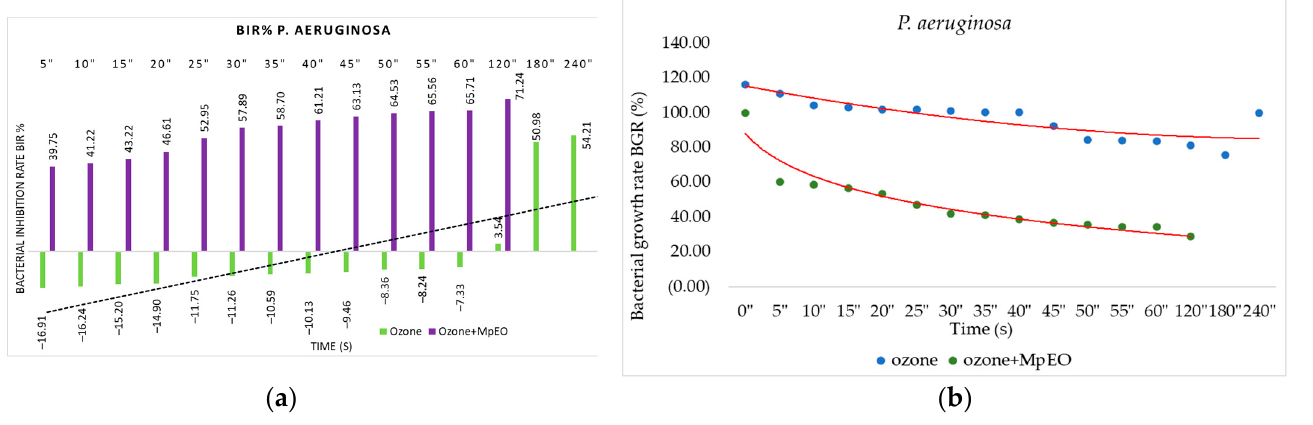
Figure 4. Ozone and ozone+MpEO antimicrobial activity on P. aeruginosa at different time exposures expressed in seconds ( ″ ). ( a ) Results expressed as BIR%; ( b ) results expressed as BGR%.